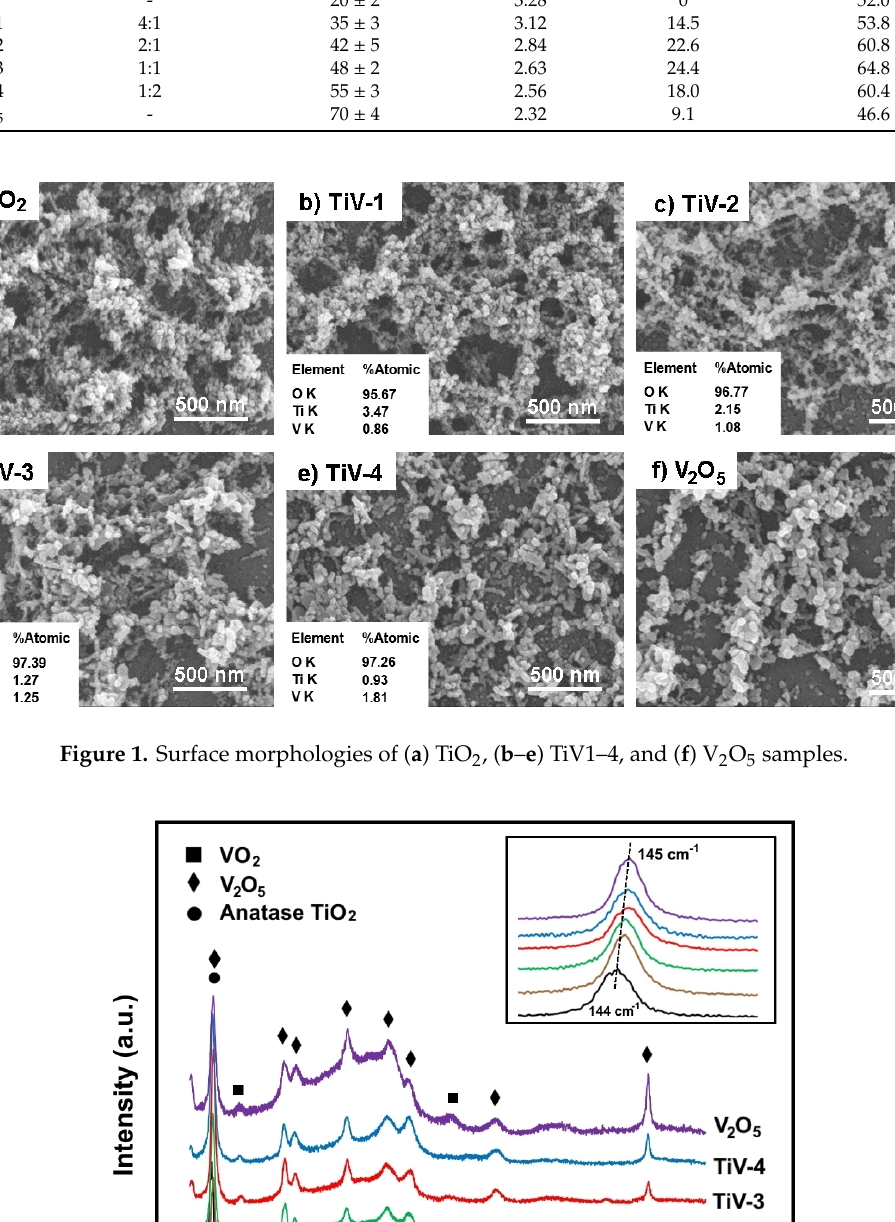
Figure 2. Raman spectra of pure TiO 2 , V 2 O 5 , and TiV1–4 composite samples .